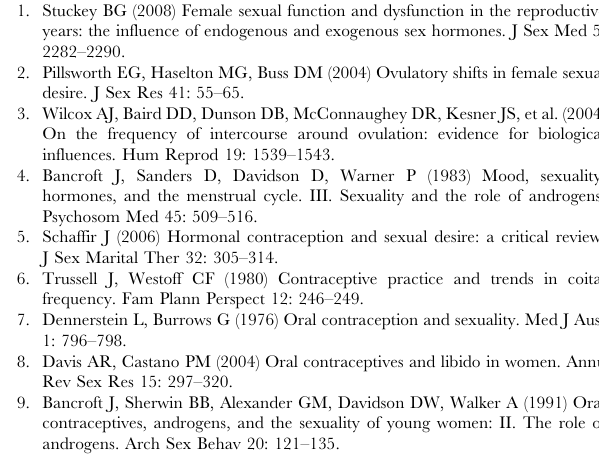
passively watch 20 erotic and 20 non-erotic pictures from the of each type of pictures was announced by arrows for 3–5 sec. Table S1 Main effects (whole brain analysis): Videos. Table S2 Main effects (whole brain analysis): Pictures. Table S3 Main effects (whole brain analysis): Expecta- tion of